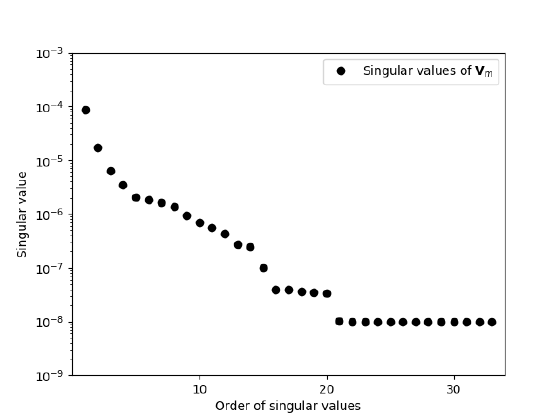
Fig. 7. Distribution for the singular values of 𝐕 𝐦